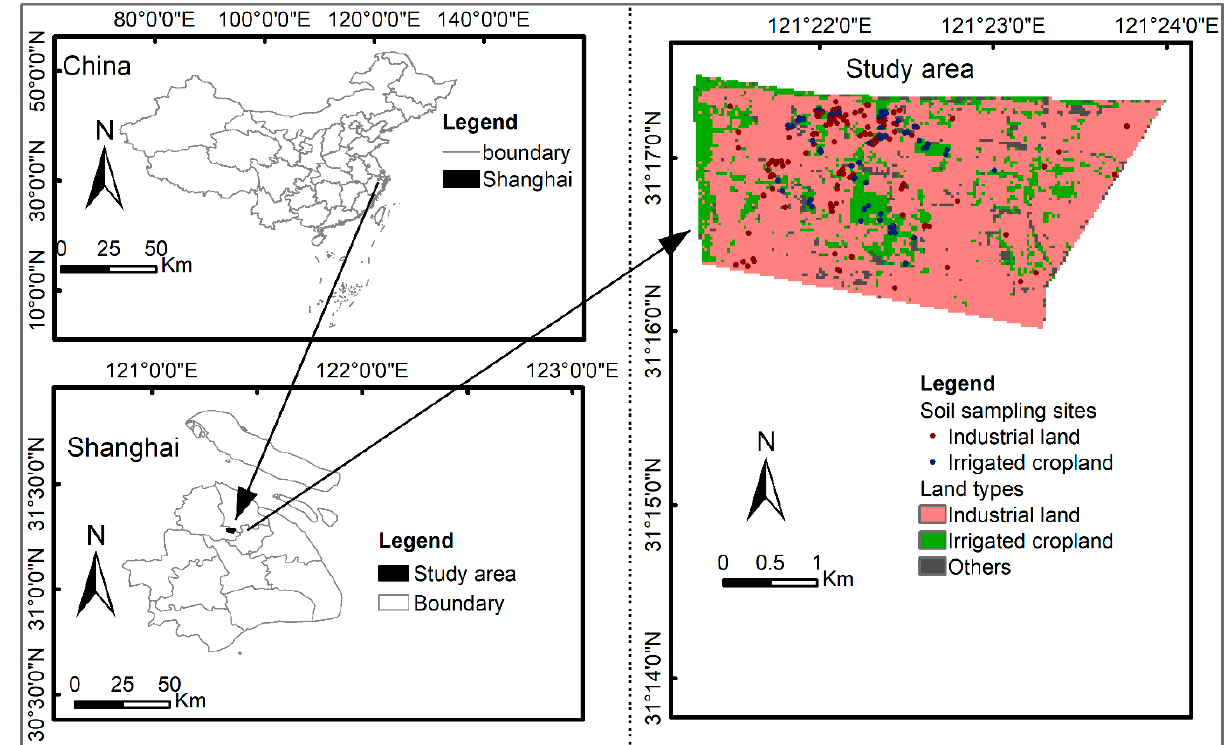
Figure 1. Location of the study area and distribution of soil sampling points.